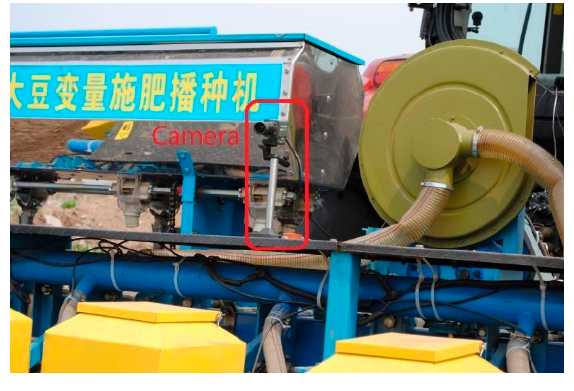
Figure 11. Test field.